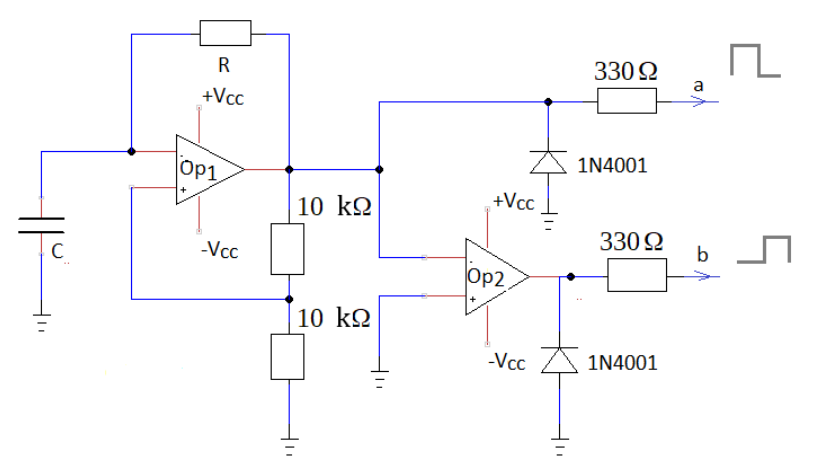
Figure 4. The circuit to produce the complementary switching signals at points a and b and then supplied to the DC-to-AC converter, as shown in Figure 3. The values R and C are programmed to tune the frequency of these commuting signals. The operational amplifiers Op 1 and Op 2 are realized by using the LM741C integrated circuit.